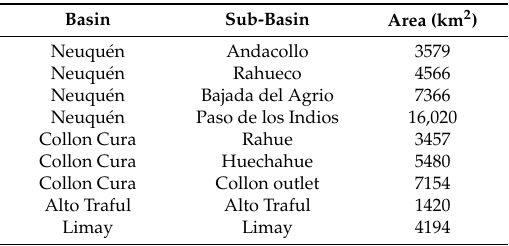
Table 2. Sub-basin discretization.